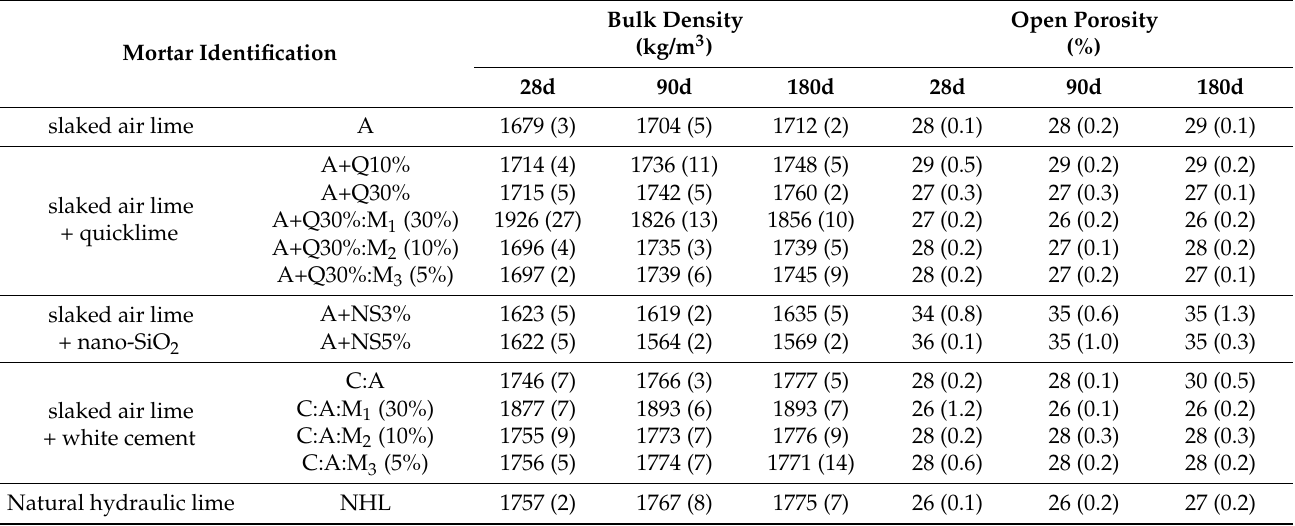
Table 4. Physical mortar